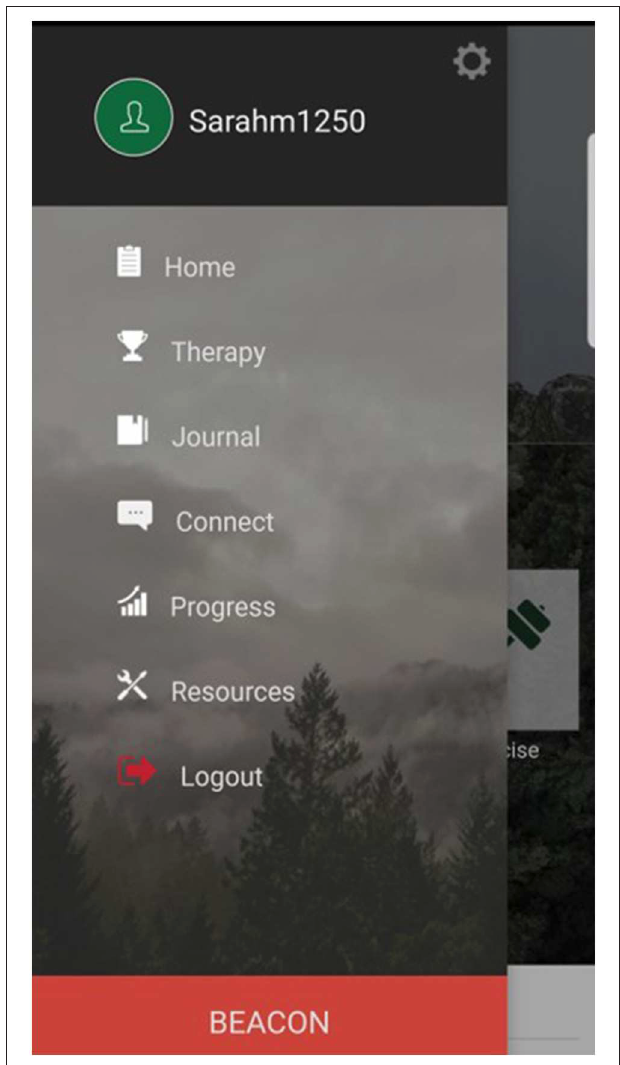
FIGURE 1 | BEACON Rx app menu